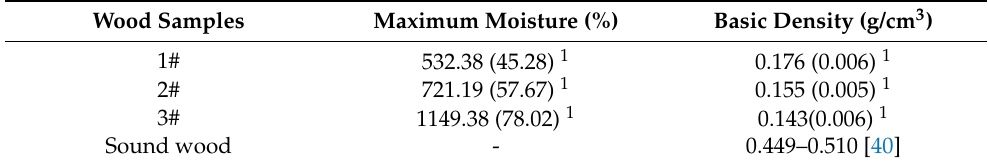
Table 1. Determination of maximum moisture and basic density. Wood